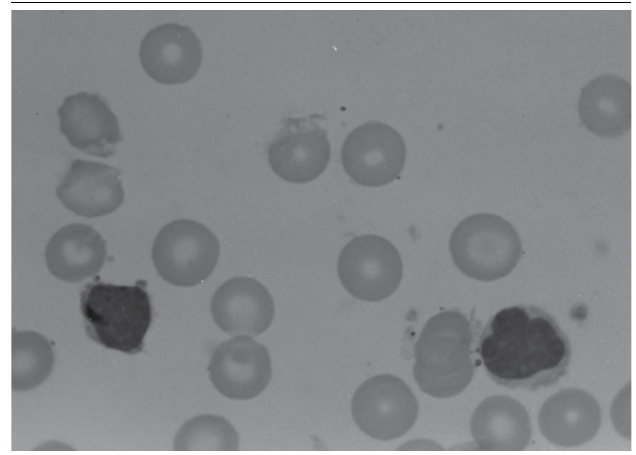
figurE 2 – Peripheral blood with small circulating lymphocytes, with irregular nucleus